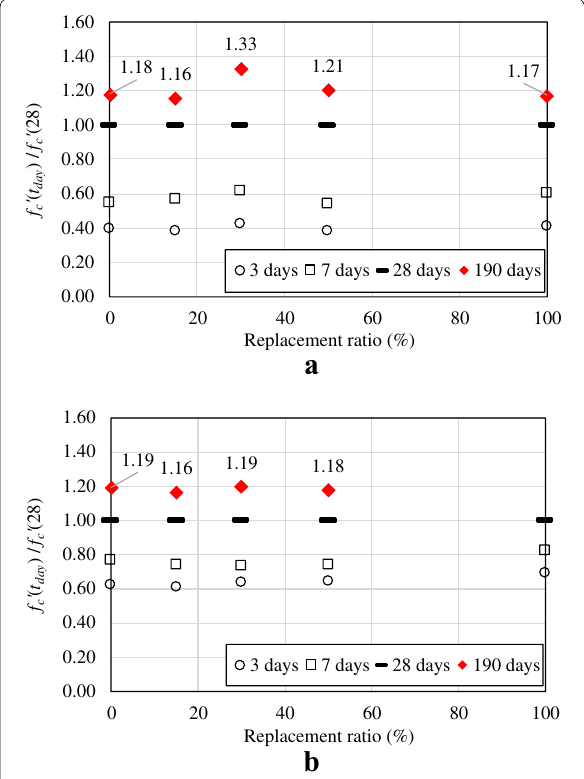
Fig. 6 Development of the compressive strength for a NS concrete, and b HS concrete.